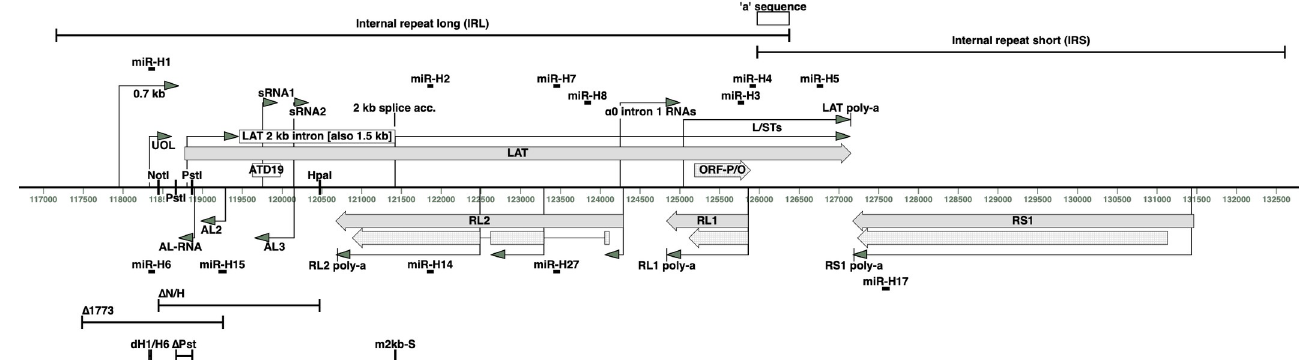
Fig 1. Schematic of the HSV-1 LAT locus RNAs. The LAT locus is duplicated in the TR L and IR L inverted repeats of the HSV-1 genome, here showing IR L next to IR S that together span 117940:127160 in HSV-1 strain 17 syn + genome (GenBank accession JN555585.1). The latency-associated transcript promoter LAP1 is followed by an enhancer element LAP2. The primary 8.3 kb LAT transcript has two exons and a 2.0 kb intron. These, together with multiple other RNAs (0.7 kb, UOL, sRNA1 and 2, α 0 intron 1 RNAs 1–4, and L/STs giving rise to the ORF-P and ORF-O proteins) and miRNAs (miR-H1, H2, H7, H8, H3, H4, and H5) transcribed from within or partially overlapping the LAT locus are known as LATs. The RL2 and RL1 genes (yielding the ICP0 and ICP34.5 proteins) are located anti-sense to LAT. In addition, many RNAs (AL-RNA, AL2, and AL3) and miRNAs (miR-H6, H15, H14, and H27) have been reported to map anti-sense to the LAT locus. The RS1 gene (ICP4 protein) and miR-H17 are on the opposite strand in IR S . The LAT, RS1, RL1, and RL2 polyadenylation sites are indicated. The LAT probe ATD19 binding site is indicated. Changes in five LAT mutant viruses used in the study are marked. The 17 Δ N/H deletion spans NotI-HpaI (118447:120472), containing LAP1, exon 1, and part of the 2 kb intron. The Δ 1773 deletion removes sequences prior to LAP1 and part of exon 1 (117486:119258). 17dmiR-H1/H6 (dH1/H6) has a 25 nt deletion removing both miR-H1-5p and miR-H6-3p (118328:118352). m2kb-S contains three mutations at the LAT 2 kb intron splice acceptor site (at 121420, 121421, and 121424 nt). The KOS Δ PstLAT deletion spans PstI-PstI (118558:118760).